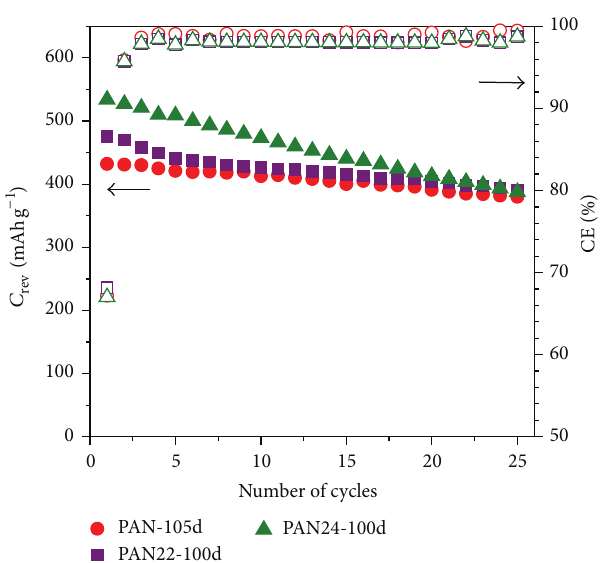
Figure 12: Cycleability of pyrolytic carbon coated PAN-105, PAN22- 100, and